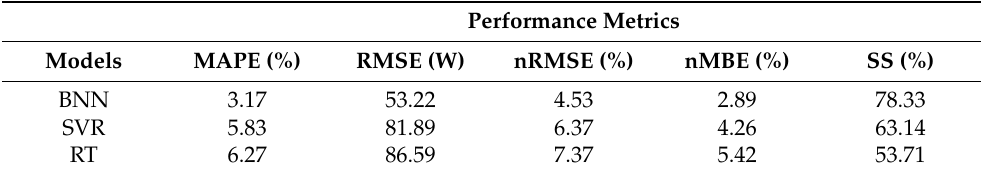
Table 6. Performance accuracy (mean absolute percentage error (MAPE), root mean square error (RMSE), normalized RMSE (nRMSE), normalized mean biased error (nMBE), and skill score (SS)) of the different data-driven models over the test set evaluation